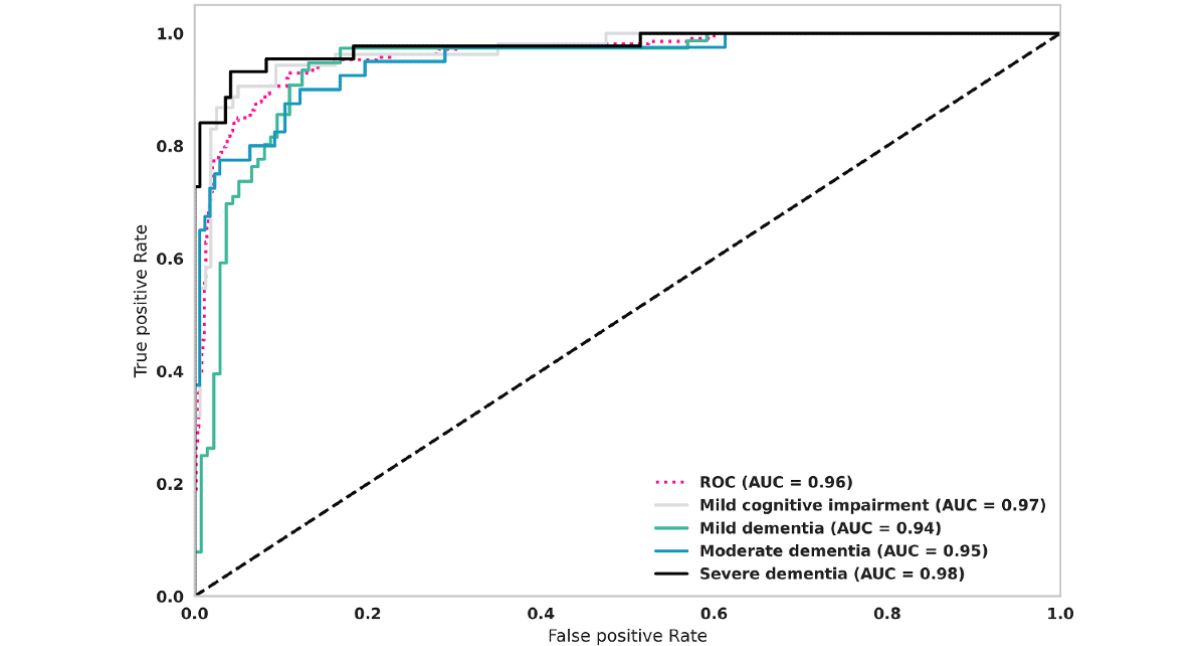
Figure 3. Receiver operating characteristic curves for each dementia stage predicted by the model. AUC: area under the curve; ROC: receiver operating